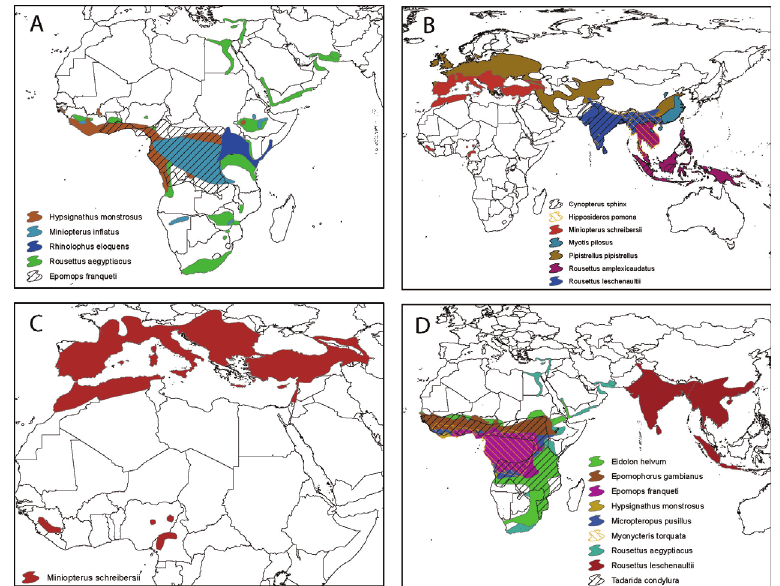
Figure 3. Geographic range for potential bat host species for ( A )